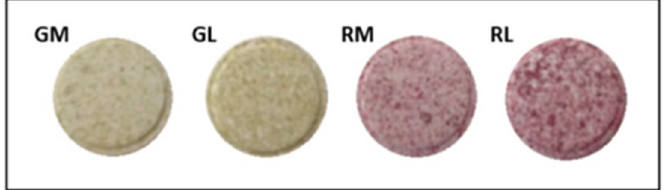
Figure 2. Images of tablet formulations of cactus pear ( Opuntia ficus- indica L. Mill) residue. GM: green cactus pear residue with microcrystalline cellulose; GL: green cactus pear residue with lactose; RM: red cactus pear residue with microcrystalline cellulose; RL: red cactus pear residue with lactose. The color parameters are shown in Table 2. Green tablets had the highest values ( p < 0.05) for luminosity ( L *), having a brighter color than red tablets. For the green tablets, the a * values were negative and b * values were positive, which places them in the green-yellow quadrant, while the red tablets presented positive values for a * and b *, corresponding to the red-yellow quadrant. The inclusion of binding agents within the same variety of cactus pear had no significant effect on a * and b * values, so the characteristic color of the fruits was preserved by the peel color itself. Both GM and GL tablets exhibited negative hue (h°) values; according to McLellan, the addition of 180° to a negative value allows us to achieve a positive one [60], and with this adjustment it was possible to determine the yellowish tonalities for the GM tablets and reddish or pink ones for the RM and RL samples. The chroma (C*) value estimates the quantitative attribute of colorfulness, with higher chroma values indicating higher color intensity of samples as perceived by humans [31]. The green cactus pear formulations (GM and GL) presented higher C* values, followed by RL and RM, so red formulations had less intense tonalities. All samples preserved the color characteristic of the variety used, and attractive colors were observed (Figure 2); therefore, it is not necessary to add artificial colors to make them attractive to the consumer. Besides, cactus pear pigments have been widely used by the food industry as an economical and stable source of pigments [61].